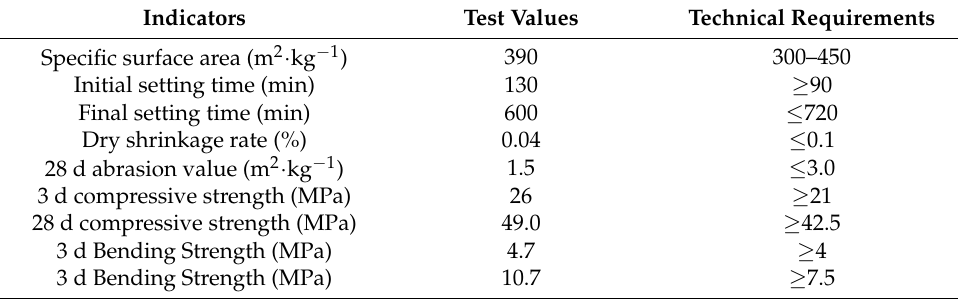
Table 1. Basic technical indicators of cement.